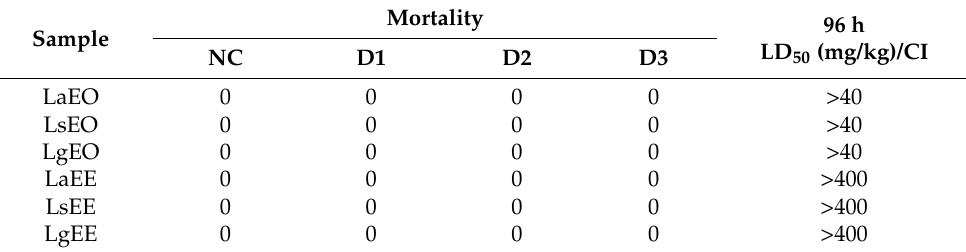
Table 4. Zebrafish mortality following the treatment with L. alba , L. sidoides , and L. gracilis .